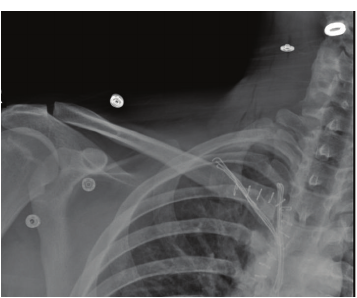
Figure 5: Postop radiographs.